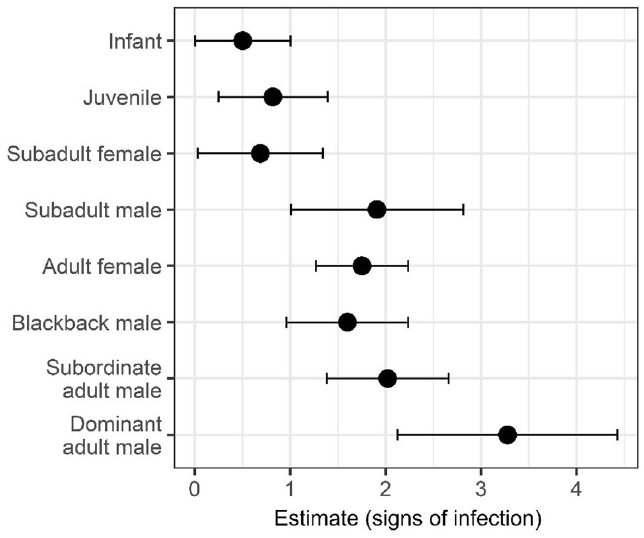
Figure 4. Estimate for the effect of each age/sex category and adult male dominance on whether signs of infection would be observed in a group member during all outbreaks (2004–2020) from binomial linear mixed models. Error bars indicate standard error. N = 274 across 15 respiratory outbreaks.